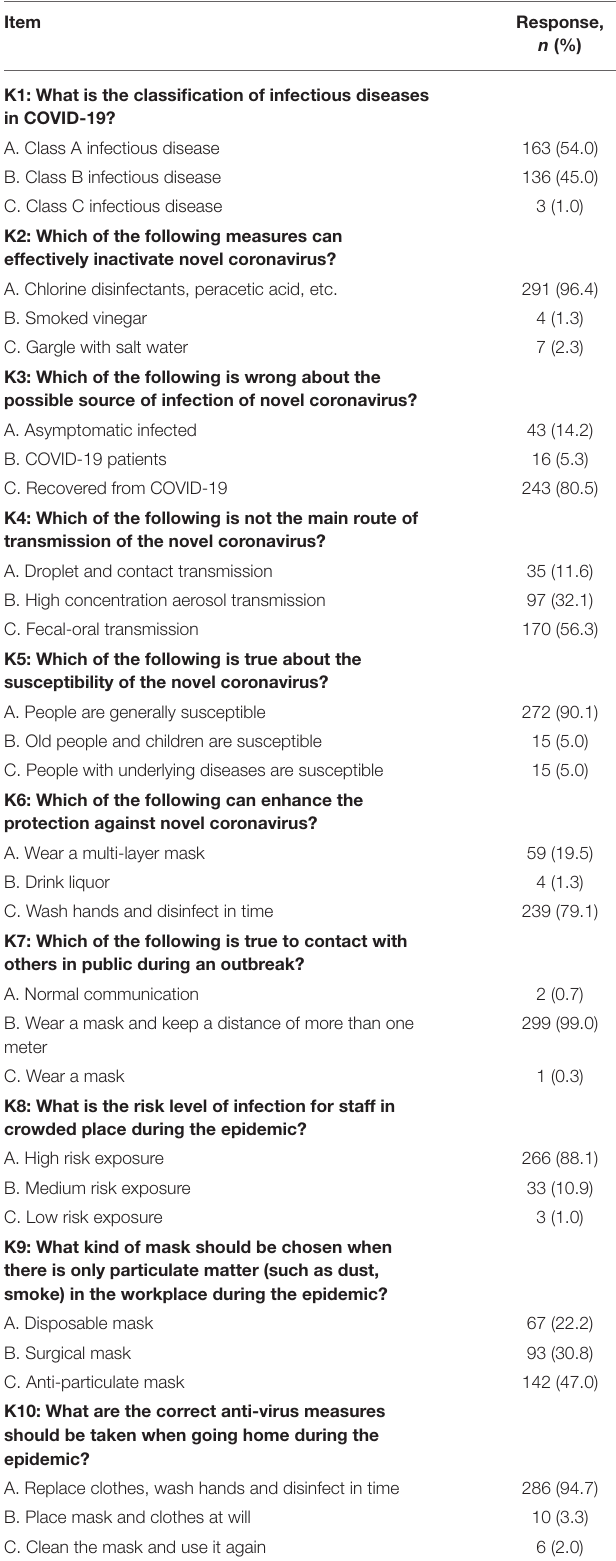
TABLE 2 | Responses to knowledge of COVID-19 among people returning to work in different occupations.